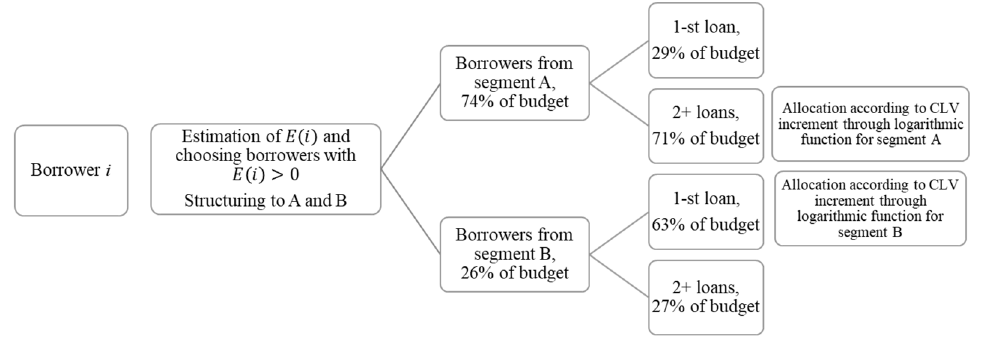
Figure 7. Model for marketing-budget allocation.